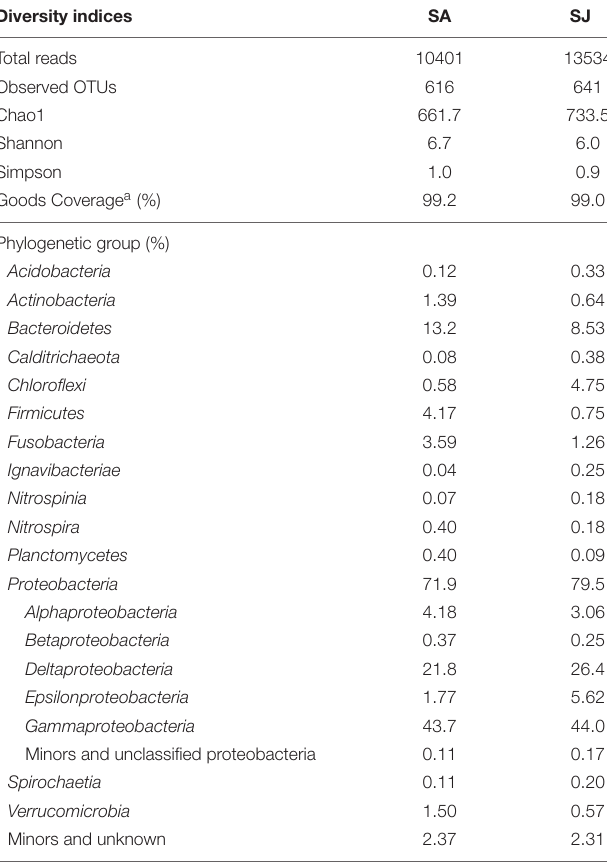
TABLE 4 | Phylogenetic composition and diversity indices of 16S rRNA genes in the 4–8 cm depth of the Ganghwa intertidal sediments. Diversity indices